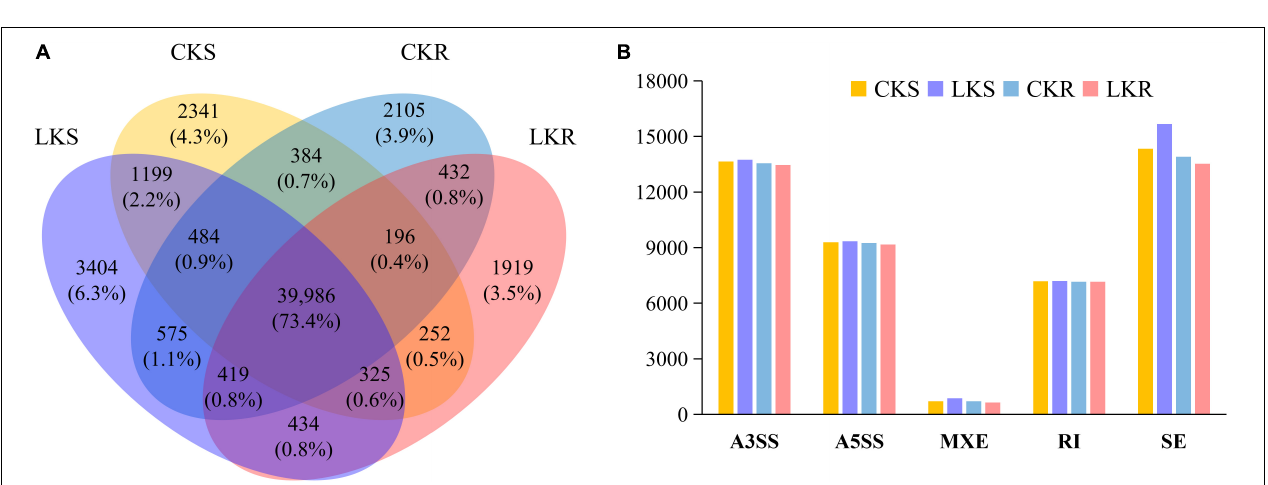
FIGURE 3 | Distribution of AS types. (A) Five different types of AS events and their frequency. The first column illustrates the structure of the AS events, followed by its name, the number, and the percentage of events; (B) The distribution of AS types in CKS, LKS, CKR, and LKR. CKS: shoot in control condition; LKS: shoot in low K + stress; CKR: root in control condition; LKR: root in low K + stress.